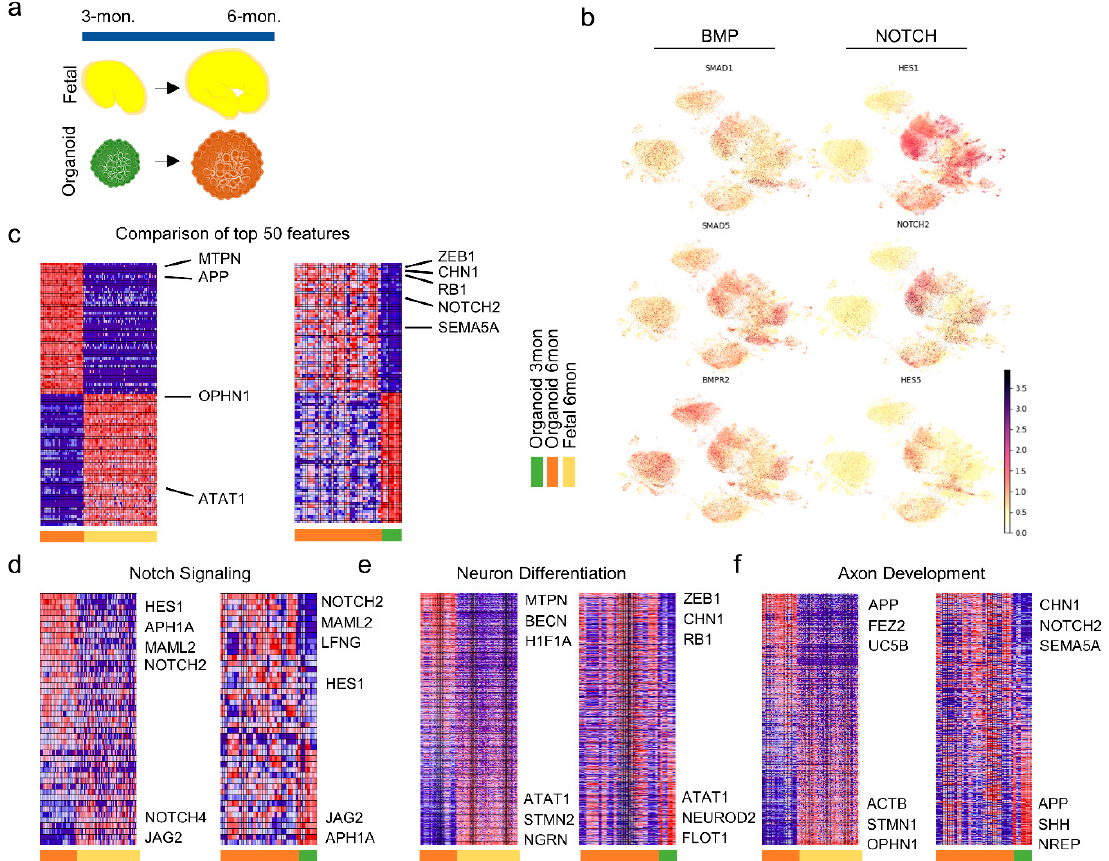
Figure 2. Gene set enrichment analysis of 3- and 6-month organoid cultures and 6-month fetal brain control groups. ( a ) Schematic of fetal brain and brain organoids at 3- and 6-month timepoints, yellow, green and brown respectively. ( b ) Expression pattern of BMP associated genes Smad1, Smad5 and BMPR2 and Notch signaling genes Hes1, Notch2, and Hes5. Intermediate BMP signaling as observed in our results has been indicated in specification of neural epidermal and neural crest lineages. Notch signaling is most predominant in astrocytes and overlaps with astrocyte markers GFAP, AQP4 and S100B and down regulated in excitatory neurons suggesting role of this signaling pathway in gliogenesis and cell fate decision between oligodendrocytes versus astrocytes. ( c ) Heatmap of the comparison and ranking of top 50 genes between 6-month organoid and control fetal group (left; Org6 vs. Fet6) and 6-month and 3-month organoid groups (right; Org6 vs. Org3). Representative genes are marked on the heatmap. Heatmaps of comparative analysis of developmental pathways including notch signaling ( d ), neuron differentiation ( e ) and axon development ( f ), as compared between 6-month organoid and control fetal group (left; Org6 vs. Fet6) and 6-month and 3-month organoid groups (right; Org6 vs. Org3). Representative pathway genes which are top ranked in the main group (Org6) has been marked on the